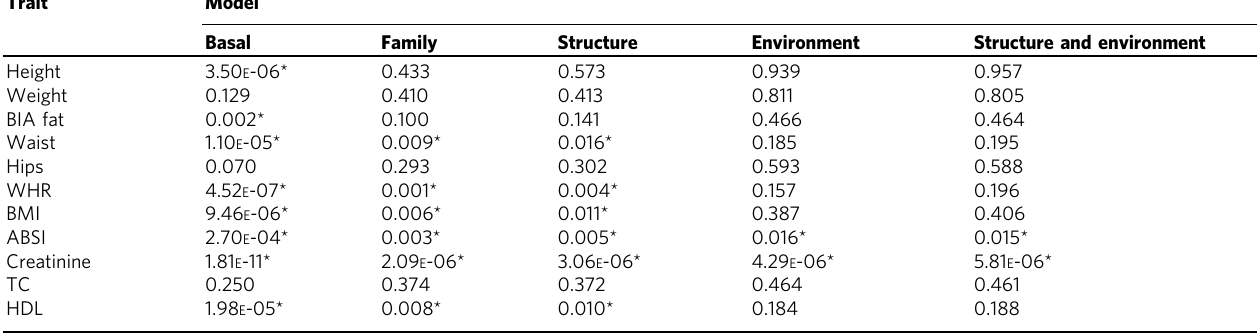
Table 1 Signi fi cance of region on phenotypes in the benchmark framework ModelTrait